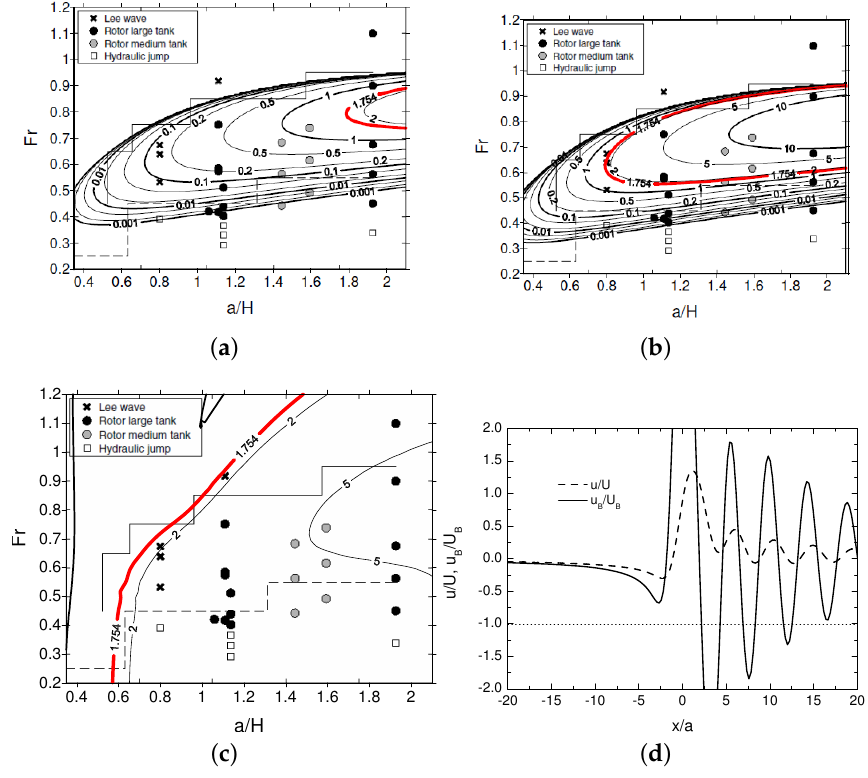
Figure 8. ( a – c ) Similar to Figure 7a–c, except that l 2 a = 1.271; ( d ) similar to Figure 7d, except that l 2 a = 1.271, Fr = 0.9, a / H =